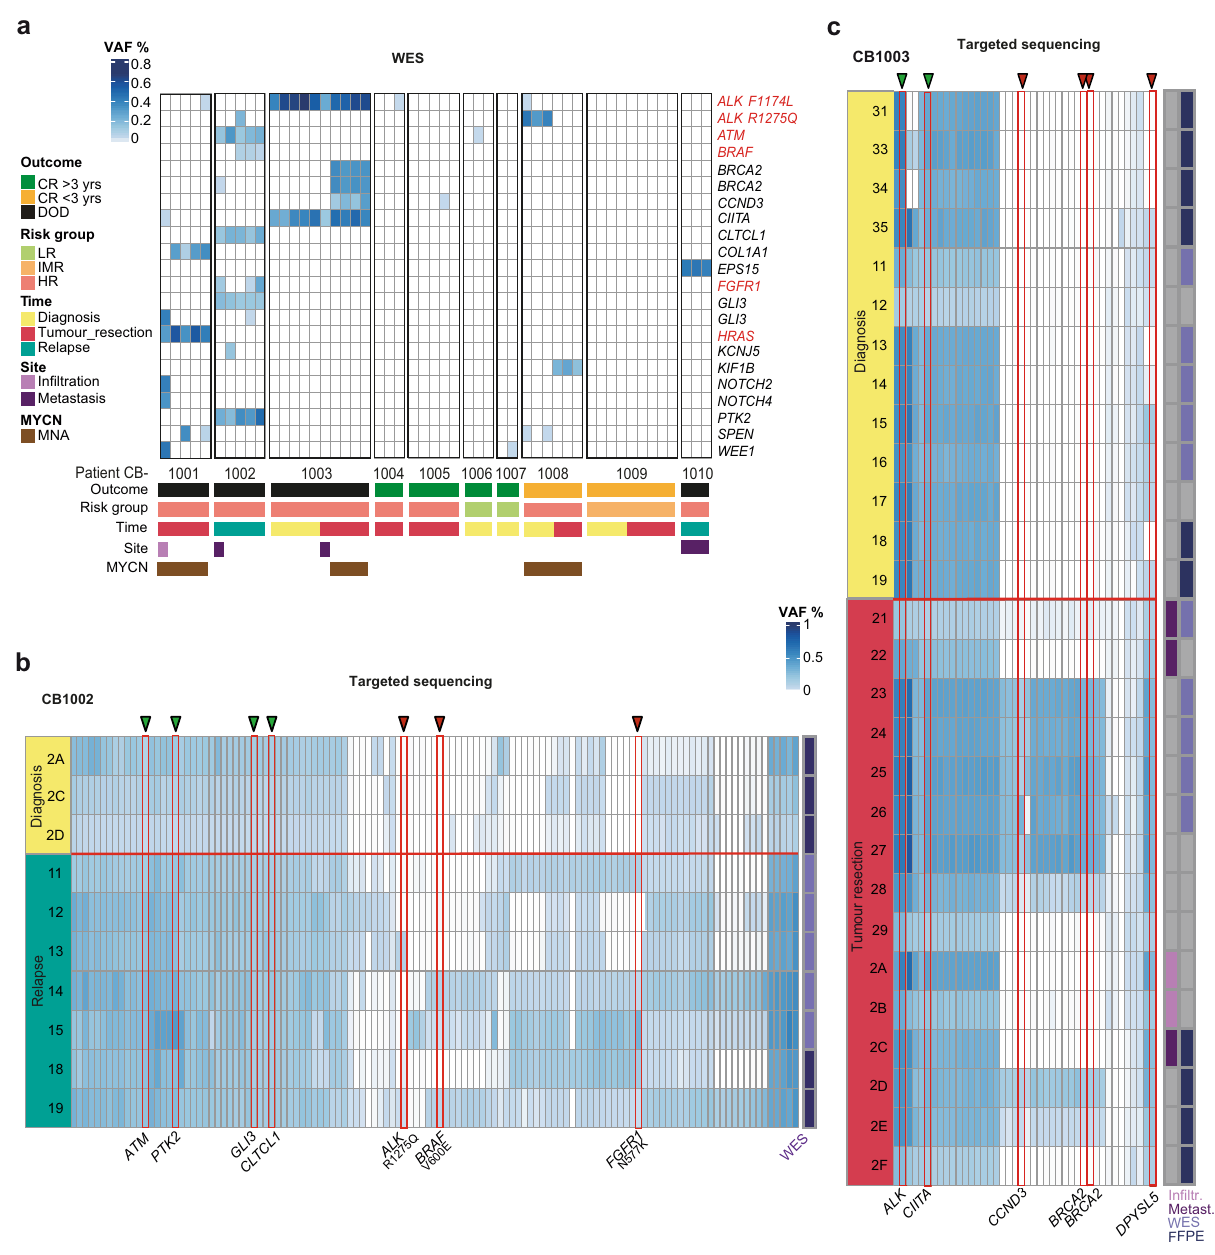
Fig. 2 ITH of SNVs in cancer-related genes analysed by WES and ultra-deep targeted sequencing. a Heatmap showing mutations in known cancer- relevant genes, based on WES of 51 tumour samples from 10 patients (CB1001 to CB1010). The frequency of mutated compared to wild-type alleles (VAF) is depicted in a blue colour code. Cancer-related genes connected to neuroblastoma genetics are marked in red. Single-nucleotide variants (SNVs) detected at separate positions in the gene are listed twice. Each column corresponds to an individual sample with samples from the same patient grouped next to each other. Clinical characteristics of patients and samples are annotated below. For 3 patients (CB1003, CB1008, CB1009), samples from different time points (Time) were analysed for the primary tumour site, distant metastasis or metastatic in fi ltration (Site). DOD: death of disease, CR: complete remission, HR: high risk, IR: intermediate risk, LR: low risk, MYCN: MYCN ampli fi cation. VAF of somatic SNVs based on targeted sequencing data from two exemplarily shown patients, CB1002 ( b ) and CB1003 ( c ). Only SNVs detected in one or more samples are displayed as one column per SNV. Mutations in cancer-related genes are explicitly named, and were indicated as clonal (VAF > 10% in all samples from a tumour, green triangles) in comparison to subclonal oncogenic mutations (red triangles). Row numbers identify samples at distinct time of biopsy collection within the disease course. Columns adjacent to the right of heatmaps indicate further characteristics. Samples denoted with WES were already included in the exome sequencing data. Samples denoted with FFPE were formalin- fi xed and paraf fi n-embedded before analysis was performed, all other samples were fresh-frozen only 3 of 7 locations and the FGFR1 N557K mutation in only 5 of molecular tumour pro fi ling as this pro fi le may not accurately 7 locations. This detailed picture of spatial heterogeneity in describe the disease in the patient. Spatial heterogeneity with actionable target genes in patient CB1002 points to a potential speci fi c mutations in the cancer-relevant genes, FGFR1 , ALK and reliability problem for the current routine practice of target ATM , among others, was also detected in other patients in our identi fi cation by single biopsy- and bulk sequencing-based cohort supporting that the spatial heterogeneity in druggable